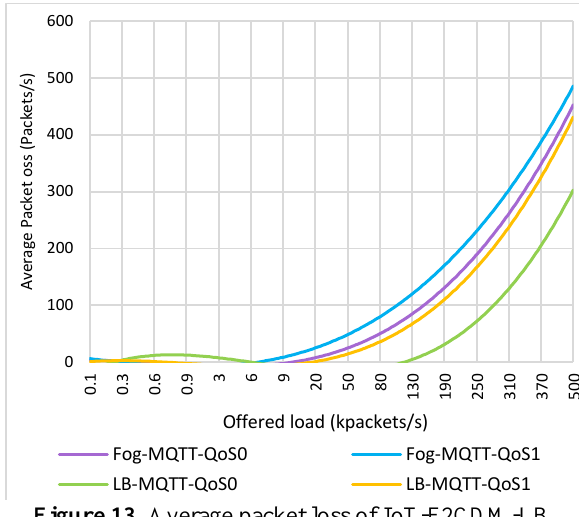
Figure 13. Average packet loss of IoT-F2CDM-LB architectures